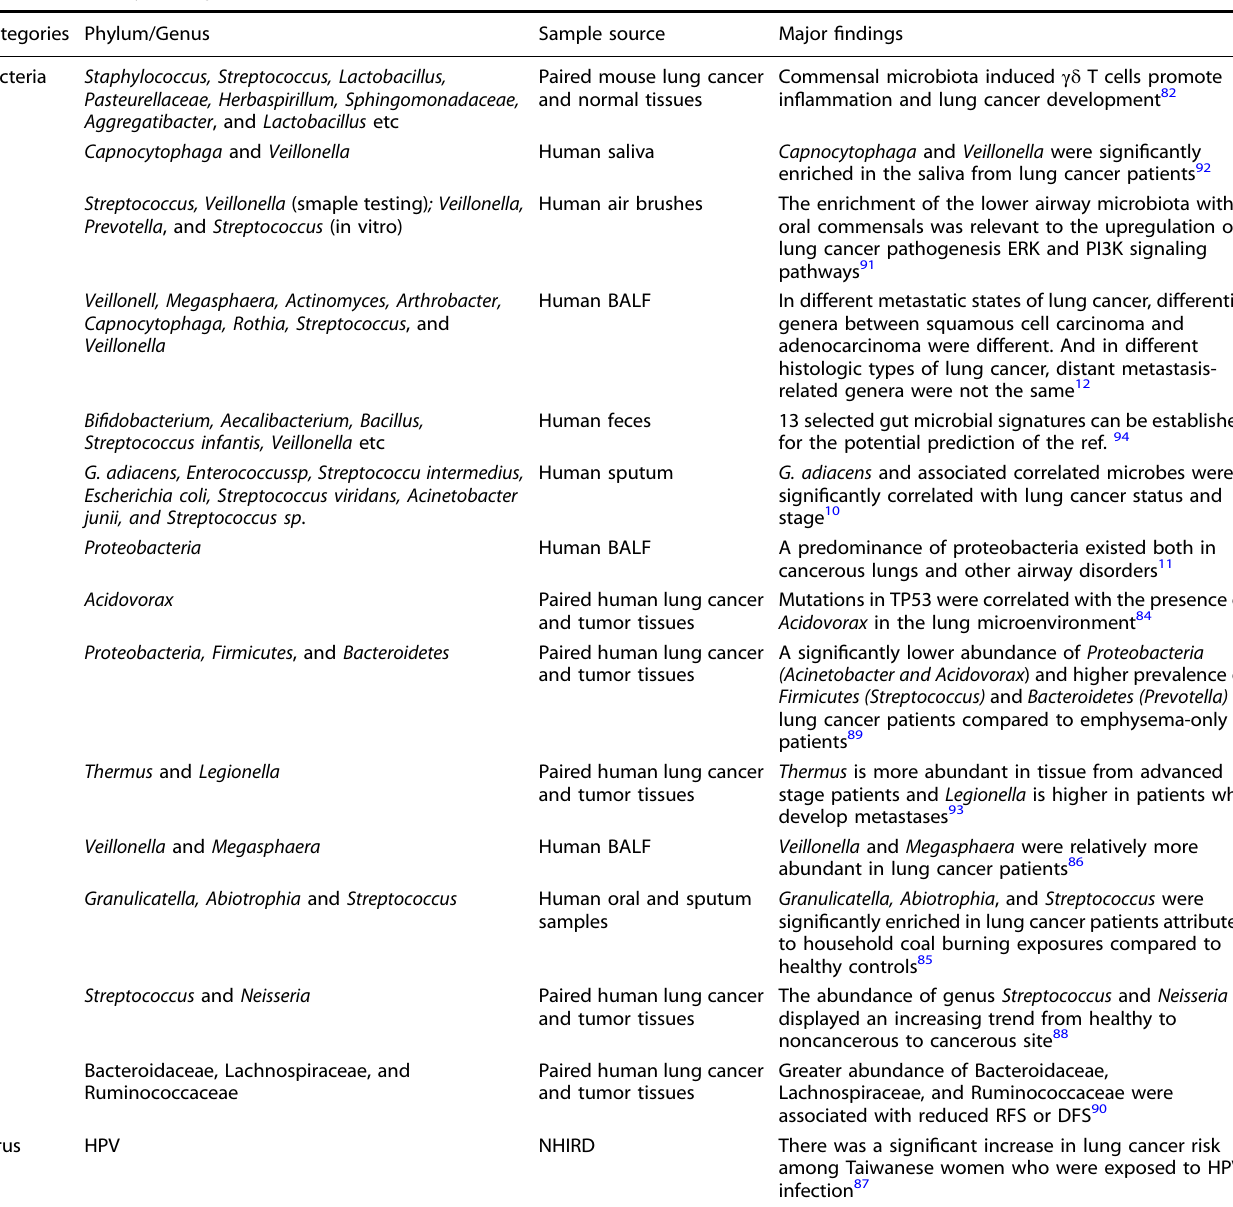
Table 1. Summary of lung cancer